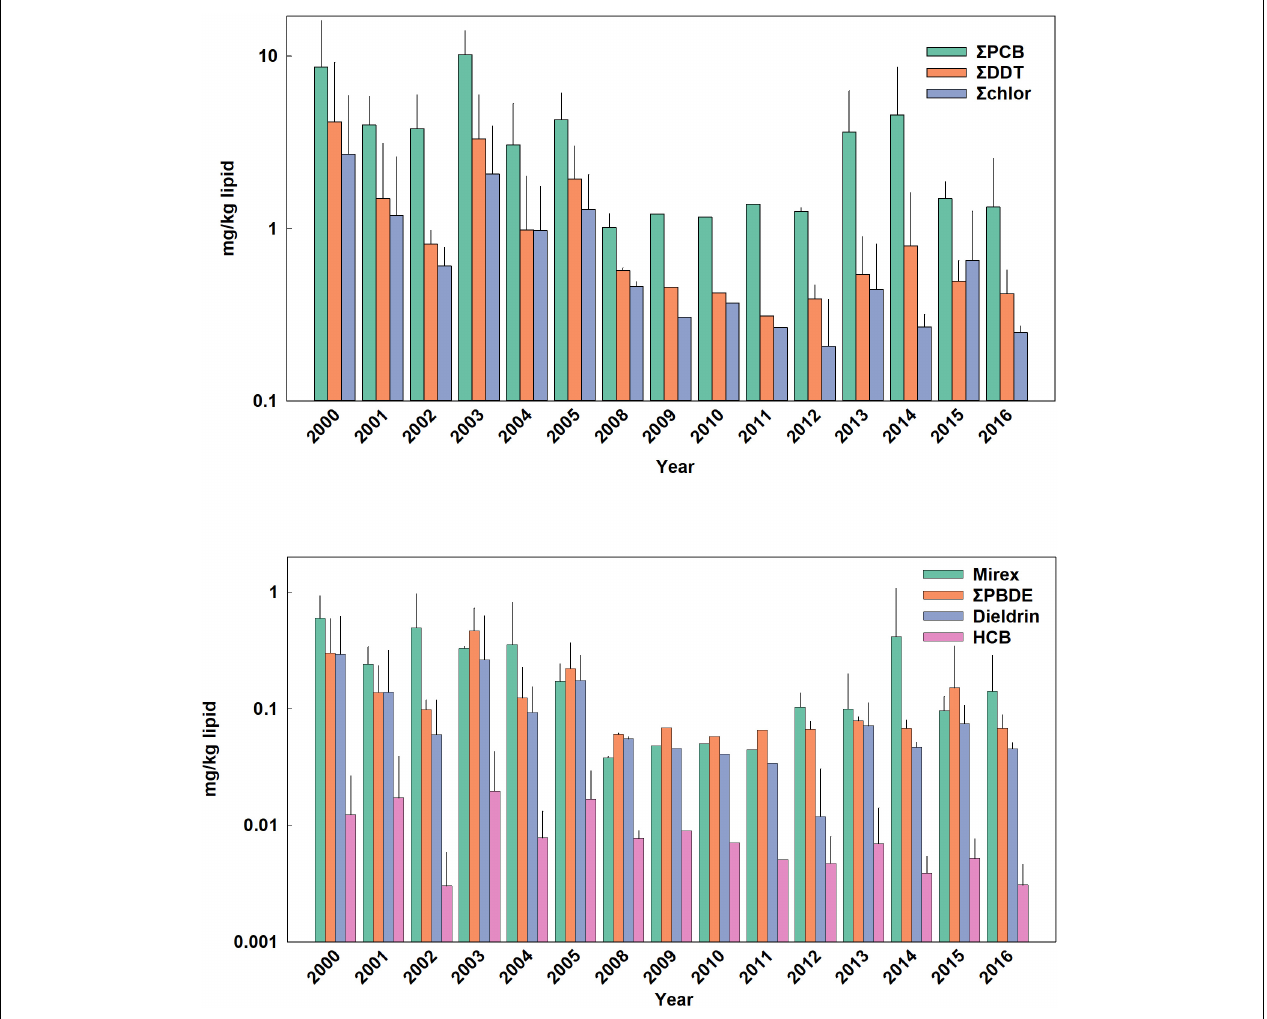
FIGURE 1 | Temporal trends of POPs in adult female bottlenose dolphins. Bars are mean ± standard deviation. Values in parentheses are for error bars that are off